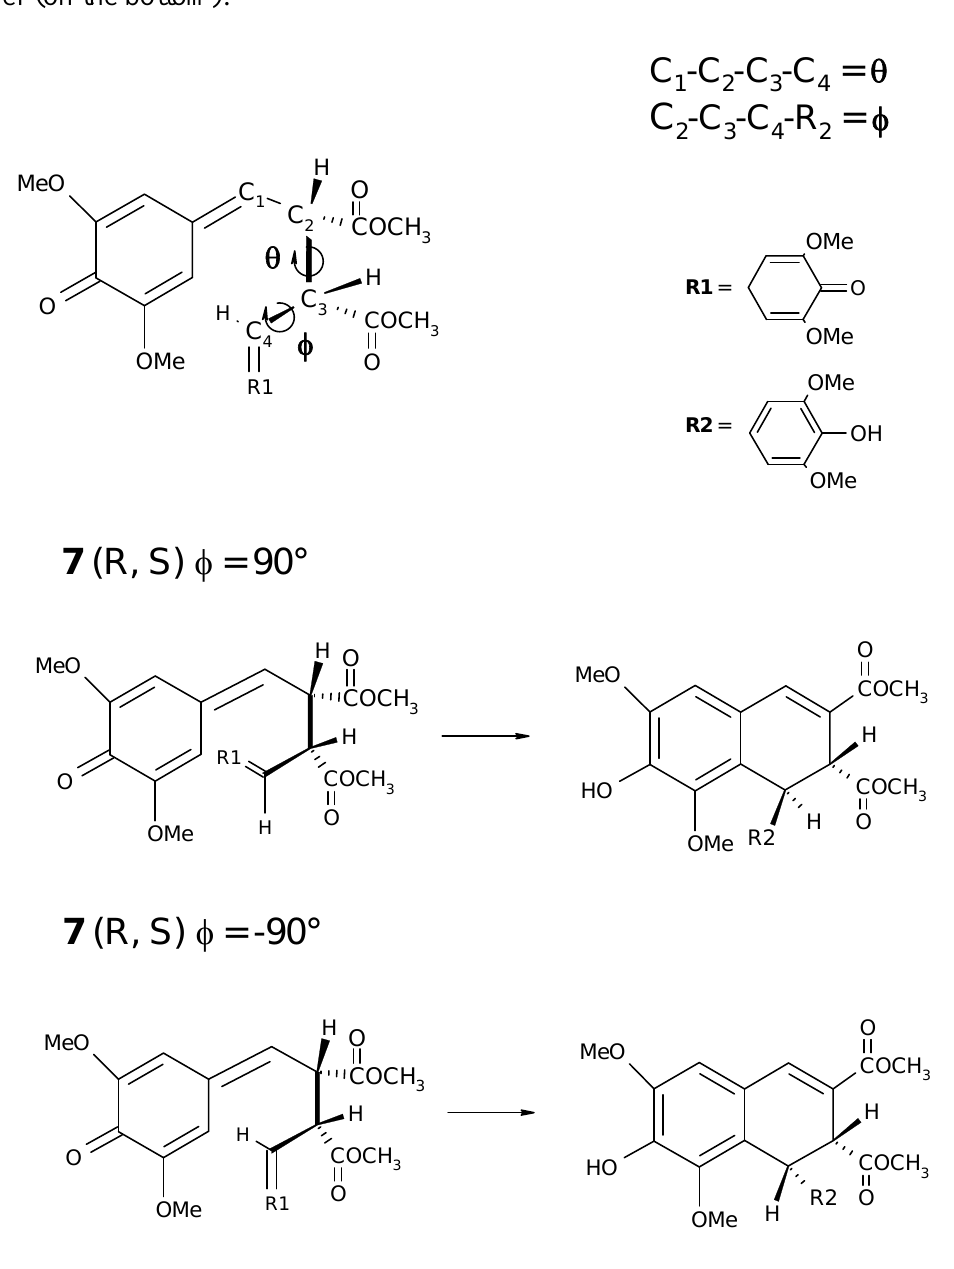
Scheme 4 . Schematic representation of the θ and φ dihedral angles (on the top). For the mesoform 2 R ,3 S positive values of the φ angle should lead to the formation of trans - thomasidioic acid 1 , while negative values the φ angle should lead to the formation of cis isomer (on the